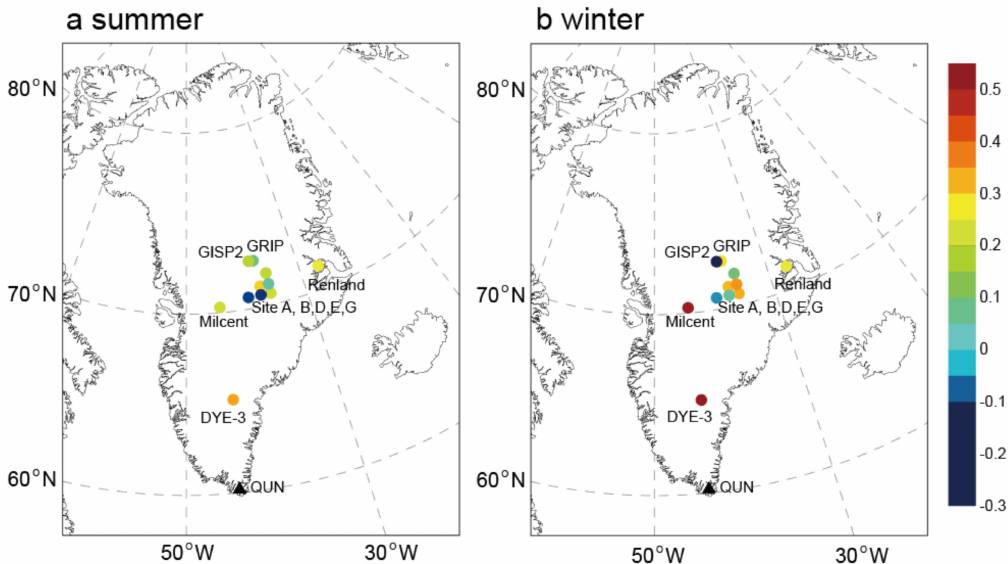
Figure 3. Spatial correlations between tree ring δ 18 O with summer ( a ) and winter ( b ) ice core δ 18 O. The time spans of the ice core records are presented in Table